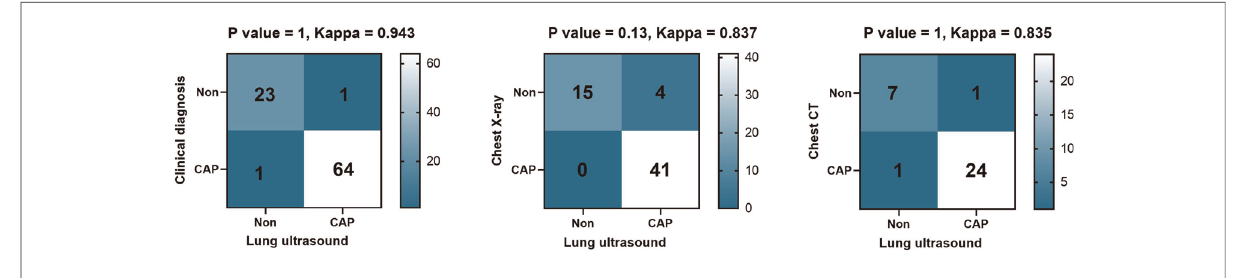
FIGURE 3 Clinical outcomes of hospitalized